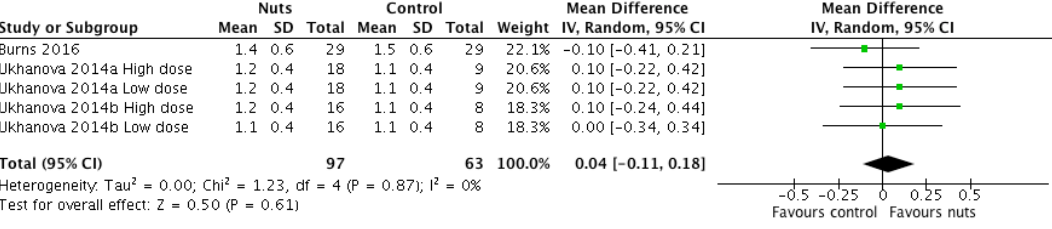
Figure 5. Forest plot of stool frequency ( n / day) of participants taking part in randomised controlled trials comparing nut consumption to control in adults. Meta-analyses were conducted using a random effects model. Values are weighted mean difference (95% confidence interval).